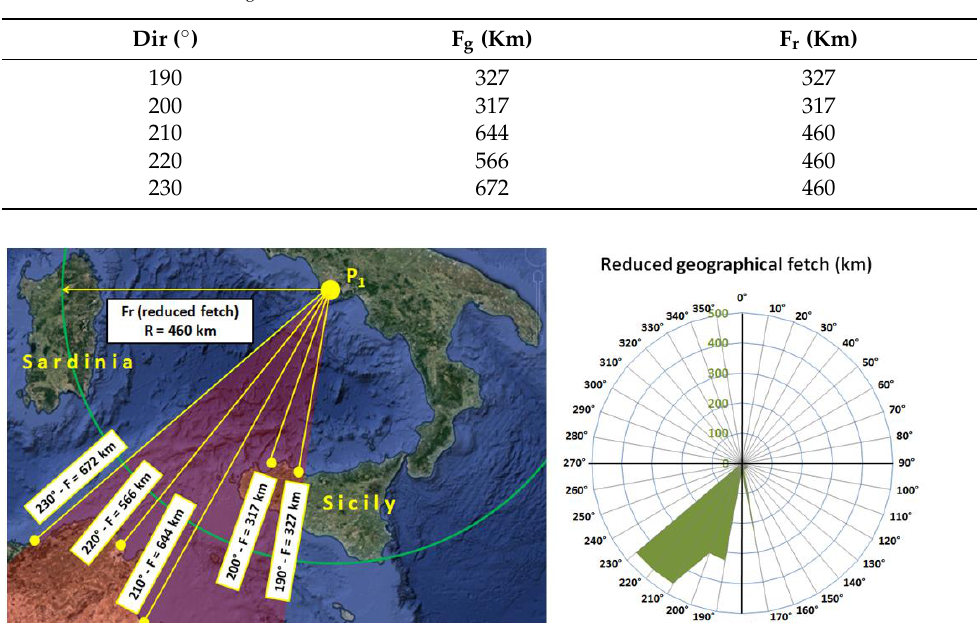
Figure 12. Meteorological map (GFS Operational 0.250°) valid on 28 December 2020-H05:00 UTC for 10 m wind (kt). There is chromatic evidence of winds with gale force. For explanation of 1 and 2 corridors see the main text. Downloaded by www.wetterzentrale.de, accessed on 6 September 2021.